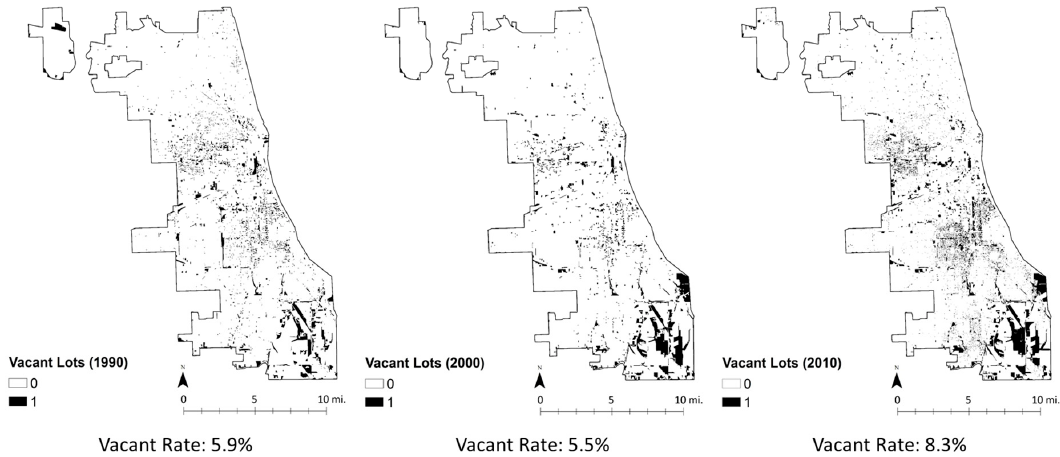
Figure 1. Historic pattern and ratios of vacant land in Chicago, IL, from 1990 to 2010 in 10-year intervals.